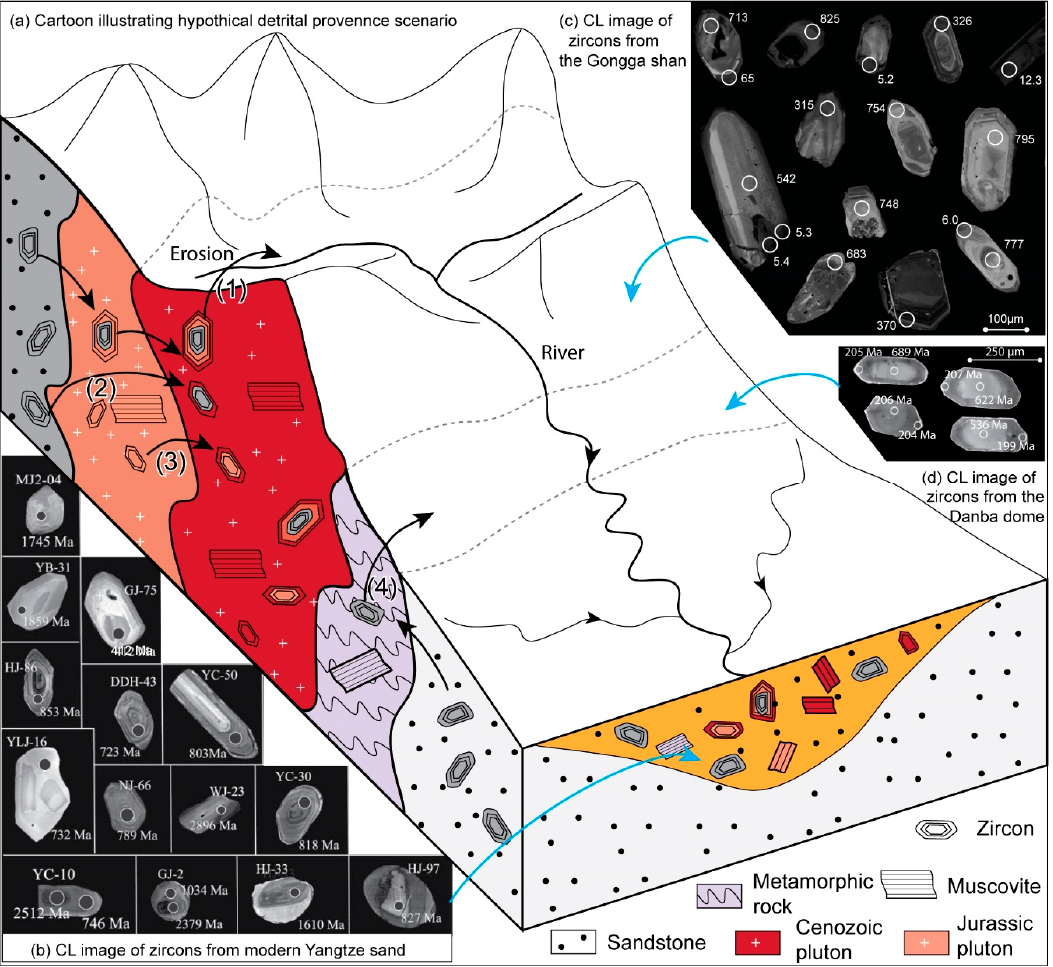
Figure 6. A cartoon showing the possible reasons for lack Cenozoic zircon in the lower reaches of the Yangtze ( a ). (1) Indicates detrital zircons experienced two phases of overgrowth. (2) Indicates overgrowth of detrital zircons in the Cenozoic. Magmatic zircon overgrowth in the Cenozoic (3). (4) Indicates no wide overgrowth of detrital zircon in the low-degrade metamorphism. Note that muscovite Ar system cannot survive magmatic or metamorphic events. ( b ) Cathodoluminescence images of detrital zircons from the Yangtze River. Images are from He et al. [21]. ( c ) and ( d ) Cathodoluminescence images of dated zircons from the Gongga shan and Danba dome, respectively. Zircon images of the Gongga shan are from Robert et al. [53]. Zircon images of the Danba dome are from Jolivet et al. [52].